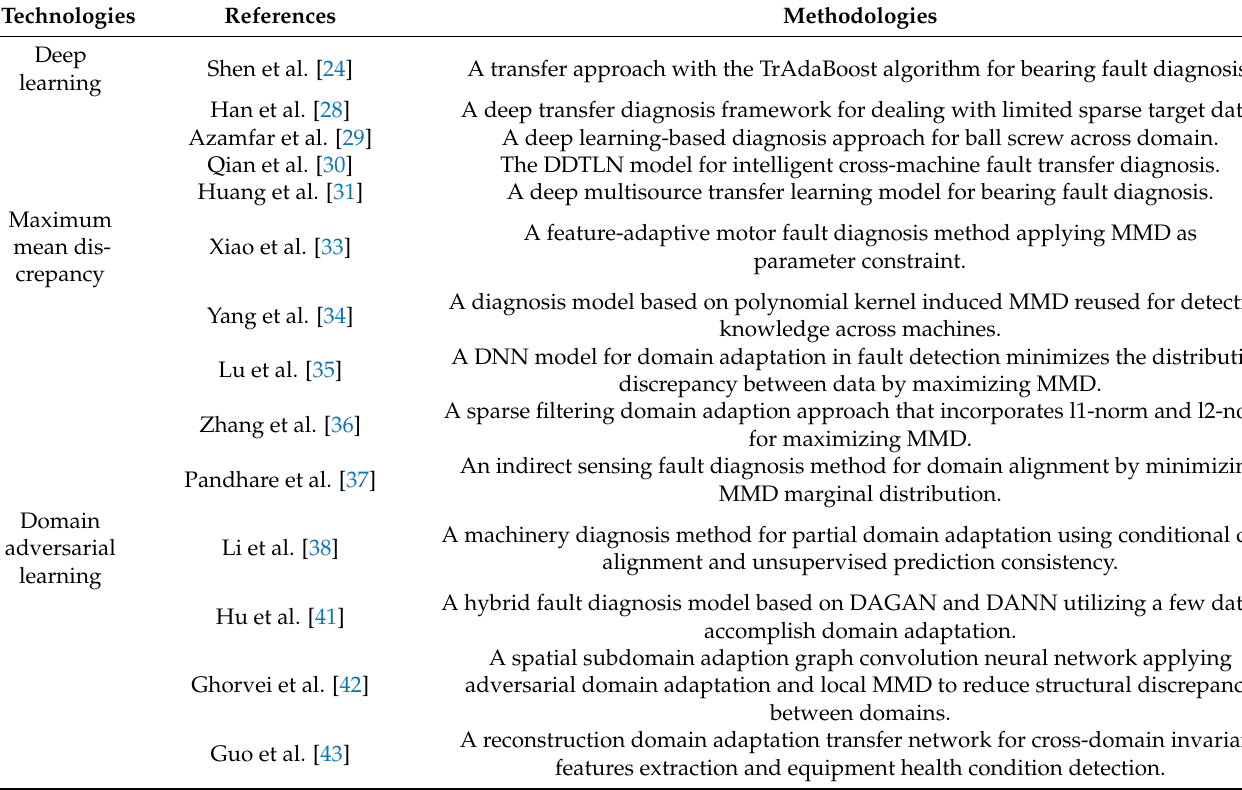
Table 1. Summary of relevant literature on fault diagnosis